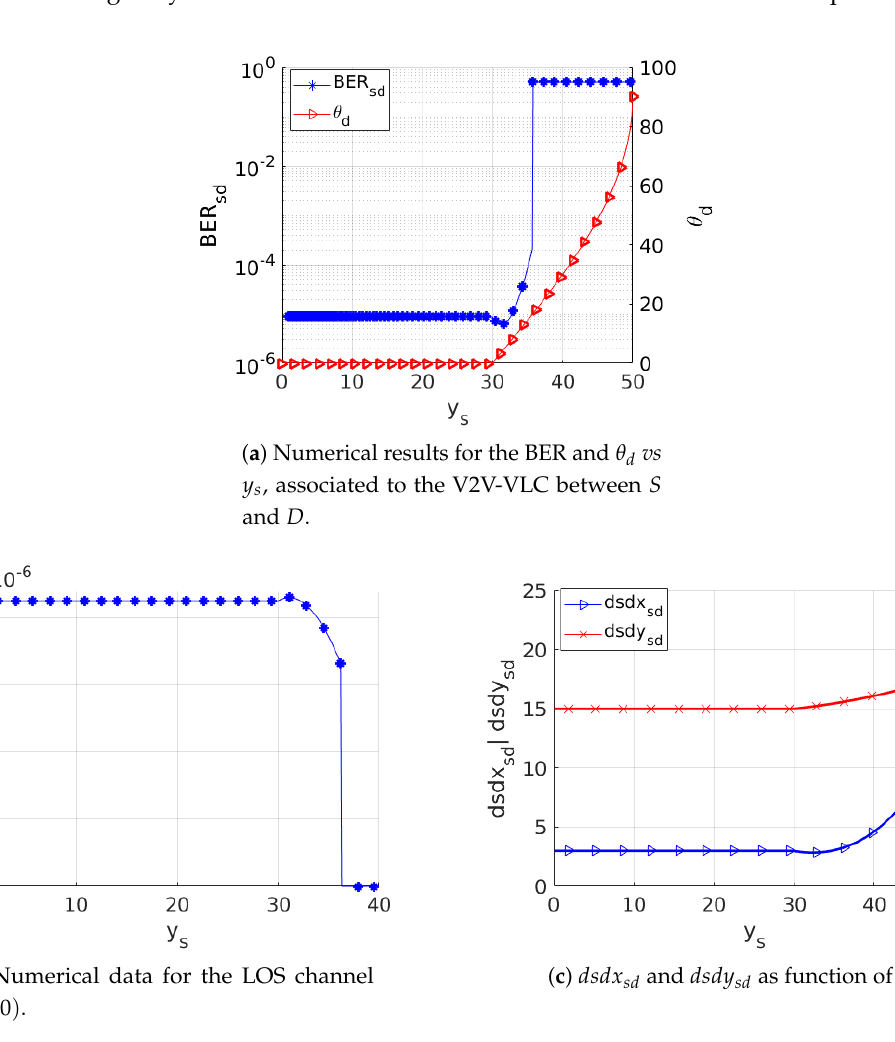
Figure 8. Performance analysis of the non-cooperative V2V-VLC along a curved roadway scenario. Table 2. Coordinates of sources and destinations for different values of θ d